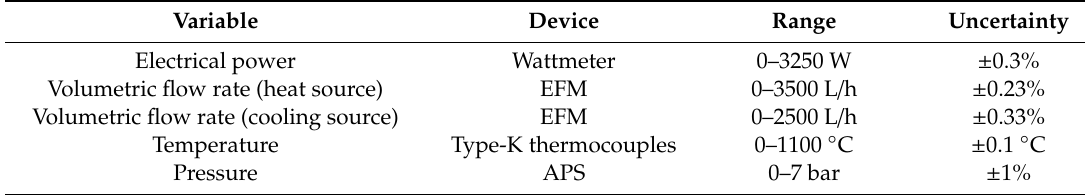
Table 2. Measurement devices’ characteristics.